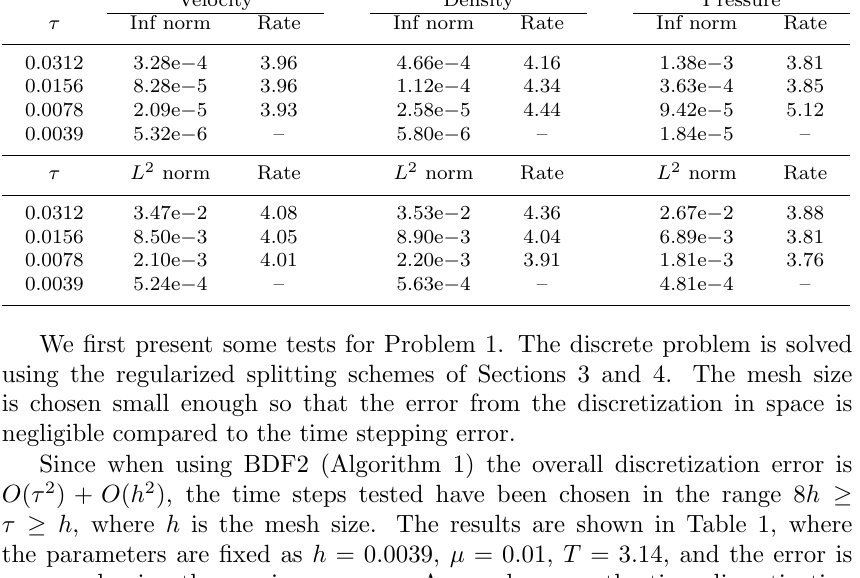
Table 1. Time discretization error, BDF2. Velocity Density Pressure τ Inf norm Rate Inf norm Rate Inf norm Rate 0.0312 3.28e − 4 3.96 4.66e − 4 4.16 1.38e − 3 3.81 0.0156 8.28e − 5 3.96 1.12e − 4 4.34 3.63e − 4 3.85 0.0078 2.09e − 5 3.93 2.58e − 5 4.44 9.42e − 5 5.12 0.0039 5.32e − 6 – 5.80e − 6 – 1.84e − 5 – τ L 2 norm Rate L 2 norm Rate L 2 norm Rate 0.0312 3.47e − 2 4.08 3.53e − 2 4.36 2.67e − 2 3.88 0.0156 8.50e − 3 4.05 8.90e − 3 4.04 6.89e − 3 3.81 0.0078 2.10e − 3 4.01 2.20e − 3 3.91 1.81e − 3 3.76 0.0039 5.24e − 4 – 5.63e − 4 – 4.81e −